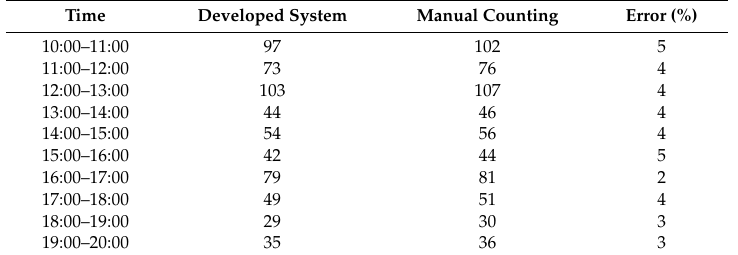
Table 5. Validation of the result between the developed system and manual